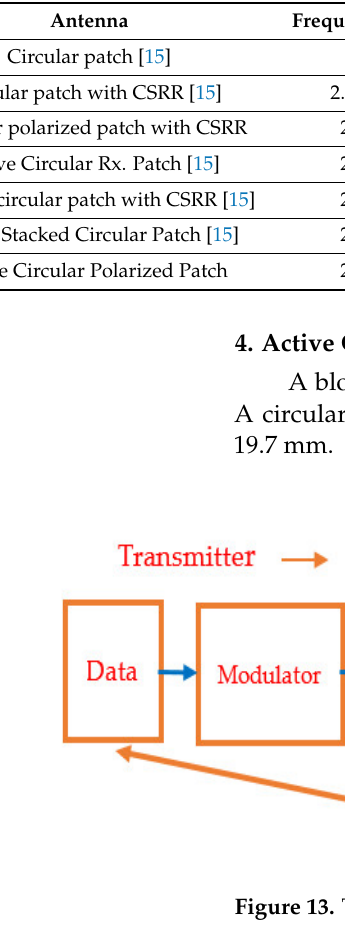
Table 6. Comparison of simulated and measured results of circular microstrip patches [15].